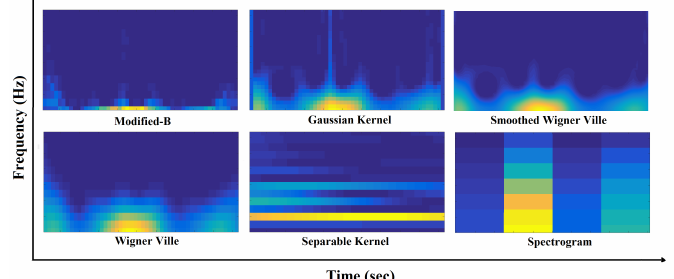
Figure 5. Time-frequency representation of one cycle data using different